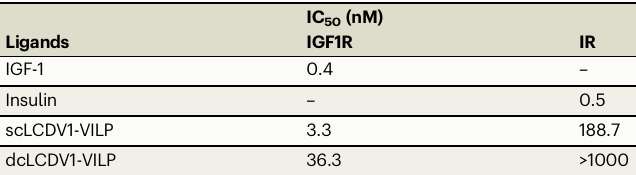
Table 1 | Receptor binding IC 50 of human IGF-1, humaninsulin, and